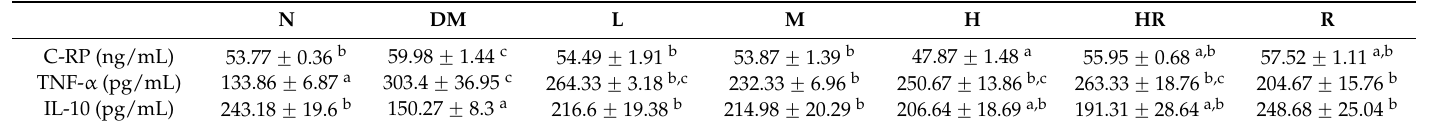
Table 4. Influence of red guava on C-RP, TNF- α , and